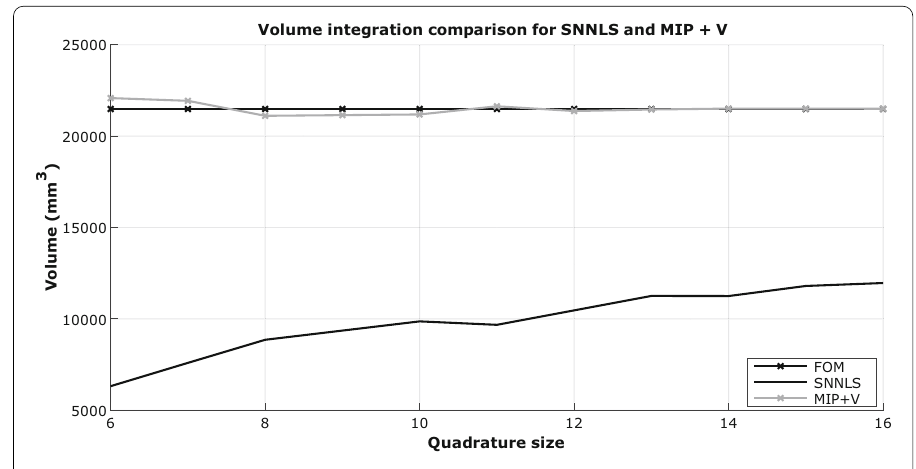
Fig. 10 Volume integration in the online reduction phase for quadratures originating from SNNLS and MIP+V